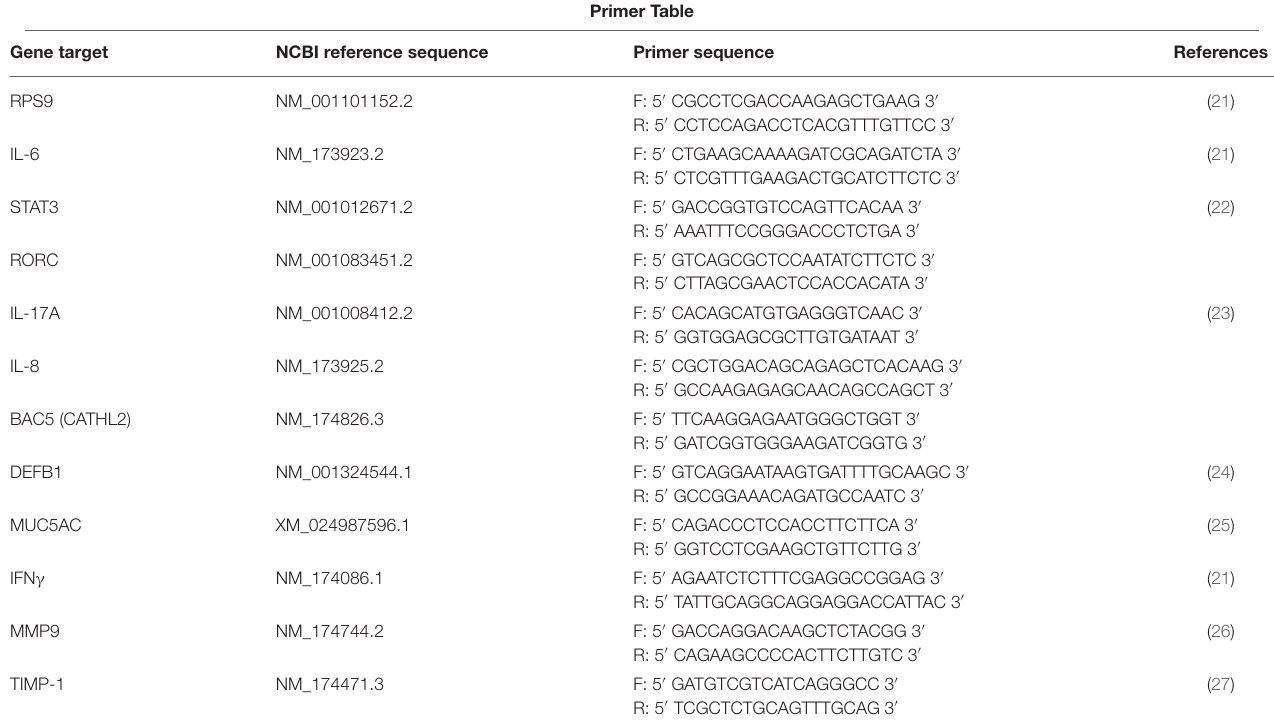
TABLE 1 | Primers for RT qPCR